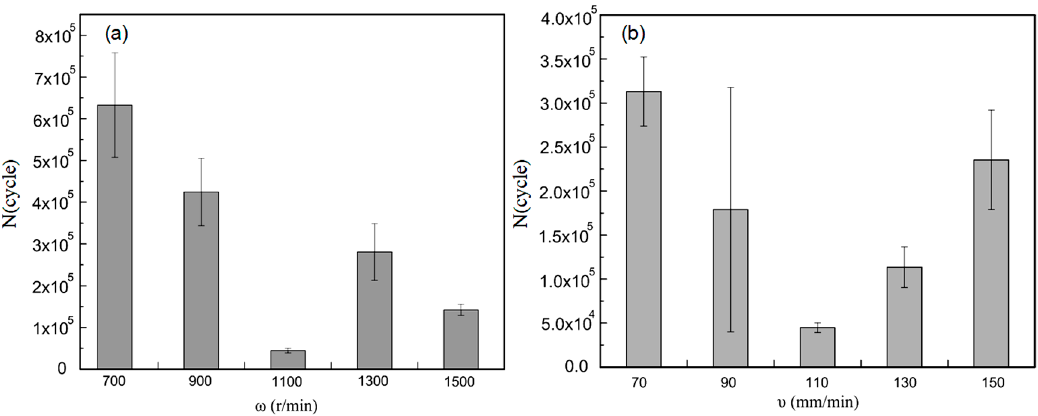
Figure 6. Fatigue lives of the repaired specimens: ( a ) ν = 110 mm/min, ( b ) ω = 1100 r/min.